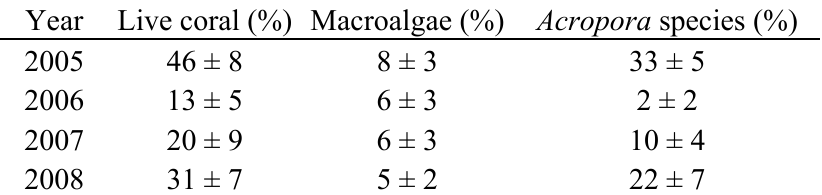
Table 1. Mean percentage cover of live coral, macroalgae and live Acropora species along transects at Dairy Bull, in 2005 (pre-bleaching), 2006, 2007 and 2008. Values are ± standard errors. Adapted from [33].